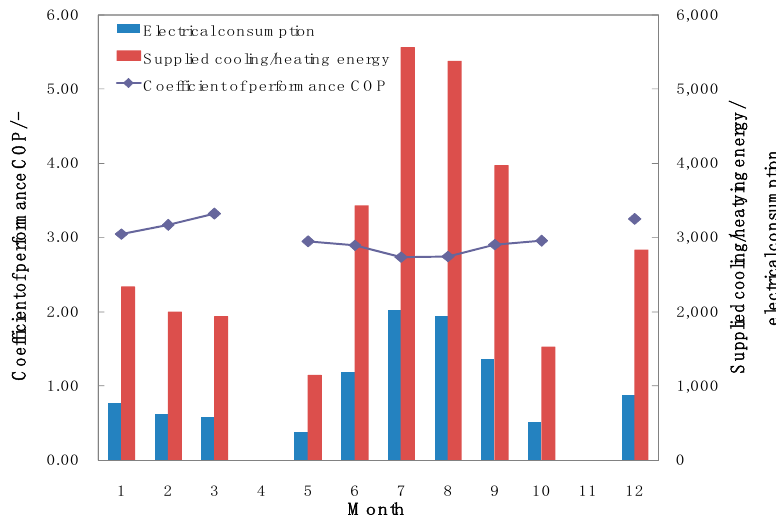
Figure 15. The monthly supplied cooling/heating energy, the electricity consumption, and the coefficient of performance of the heat pumps COP hp in 2018.